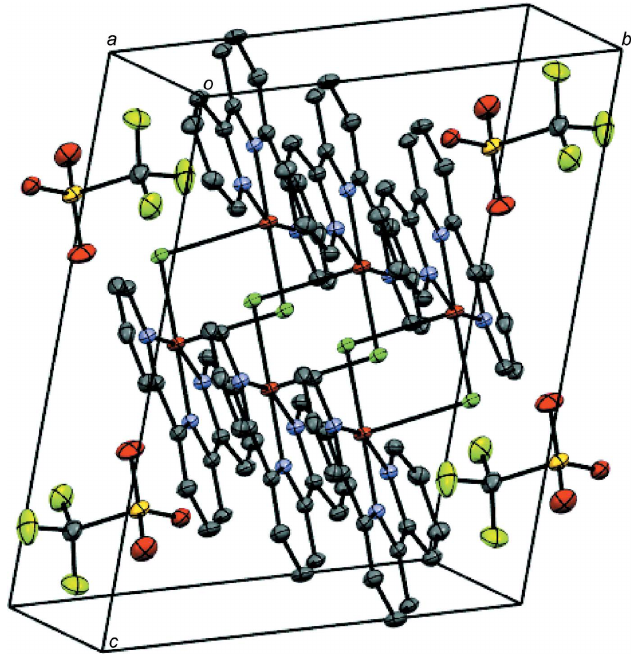
Figure 2 Perspective view of the packing structure of the title complex along the crystallographic a -axis; H atoms are omitted for clarity.